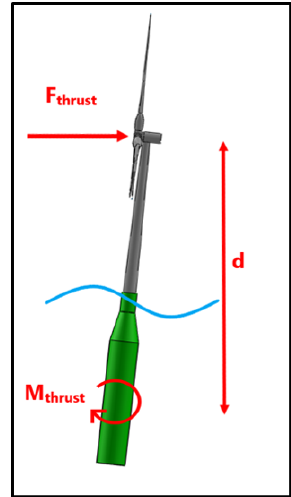
Figure 8. Thrust moment and force acting on the floating